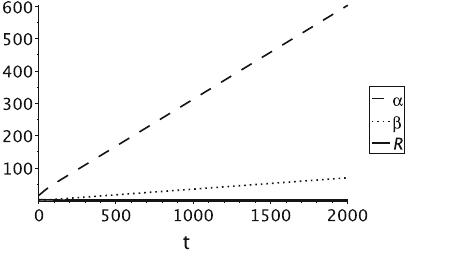
Eq. (11). The values of H 1 (cid:4) 0 . 290696 , H 2 (cid:4) 0 . 035163 coincide with those found from (13), (14), (15) equations. The Lagrangian parameters are k = − 2 . 98 , a = − 2 . 77 , c = − 0 . 49